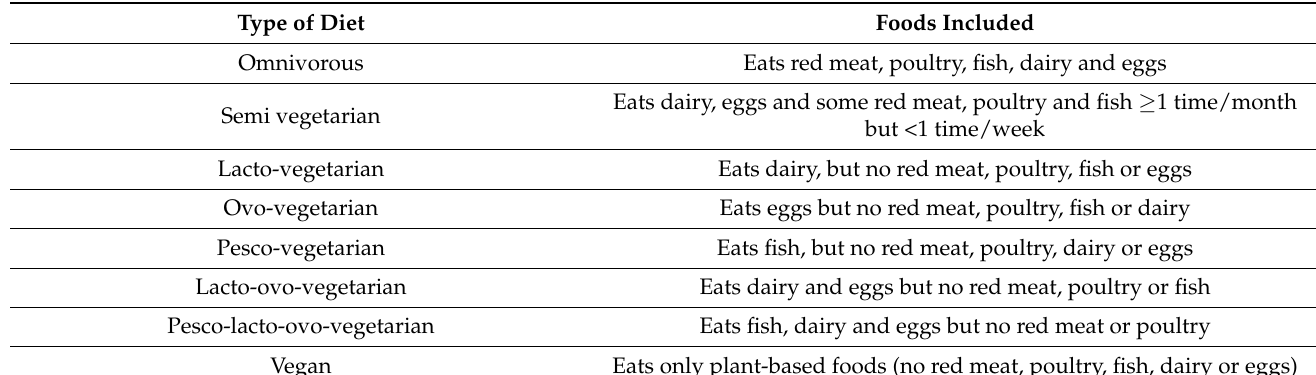
Table 1. Properties of diets (adapted from